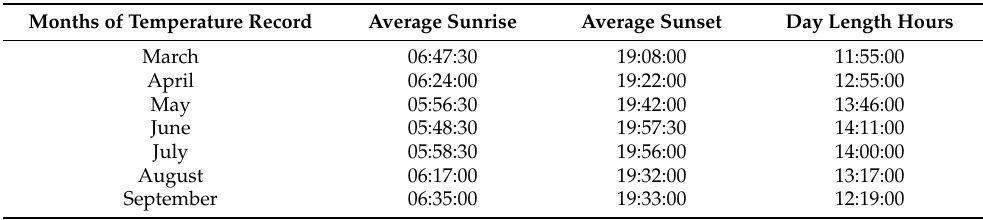
Table 1. Average day length hours during the months of temperature logger records in the city of